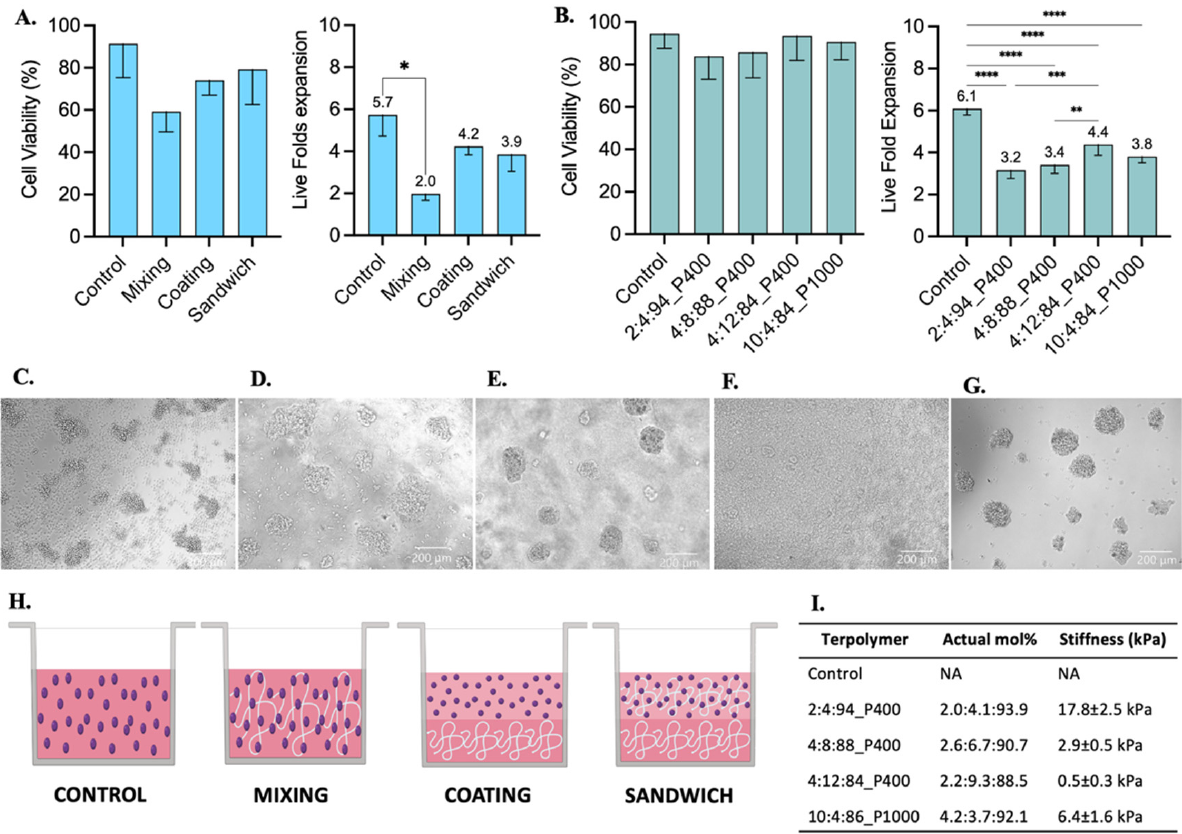
Figure 6. Jurkat T cell culture testing with 2:4:94 P400, 4:8:88 P400, 4:12:84 P400, and 10:4:86 P1000 terpolymer combinations after 48 h of incubation. ( A ) Cell viability and live fold expansion using mixing, coating, and sandwich conditions of terpolymer scaffolds to test 2:4:94 P400 terpolymer. ( B ) Cell viability and live fold expansion using the sandwich condition with different terpolymer combinations. Brightfield pictures of ( C ) suspension cell culture as control, encapsulated cells within ( D ) 2:4:94 P400, ( E ) 4:8:88 P400, ( F ) 4:12:84 P400, and ( G ) 10:4:86 P1000. Scale bar: 200 µm. ( H ) Graphical representation of conditions employed to test terpolymer scaffolds with Jurkat T cell culture. Control: Cells in the same working volume as other conditions. Mixing: mix of 1:1 proportion of terpolymer solution with cells in suspension. Coating: Cells seeded on top of a previously made polymer-coated well. Sandwich: Mixing of cells with terpolymer seeded on top of a terpolymer coating. ( I ) Summary of principal characteristics of terpolymer tested with Jurkat T cells. The graphs show means and STDV values of n = 6 wells, except for cell viability which expresses error propagation. p -values: blank (not significant), 0.0078 (*), 0.0057 (**), 0.0003 (***), <0.0001 (****).